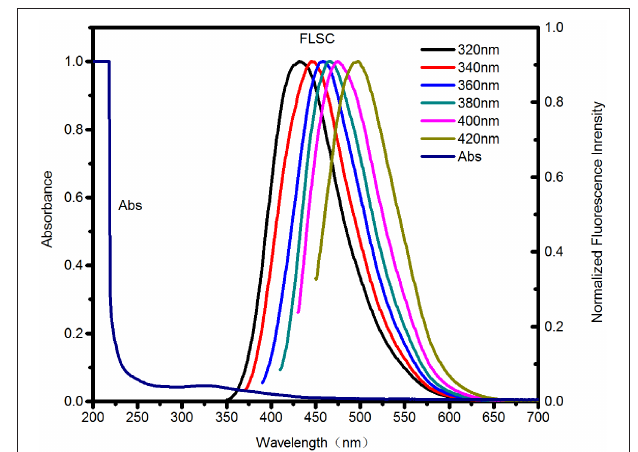
1,682, 1,585, 1,250, and 1,101 cm − 1 belonged to C = O stretching